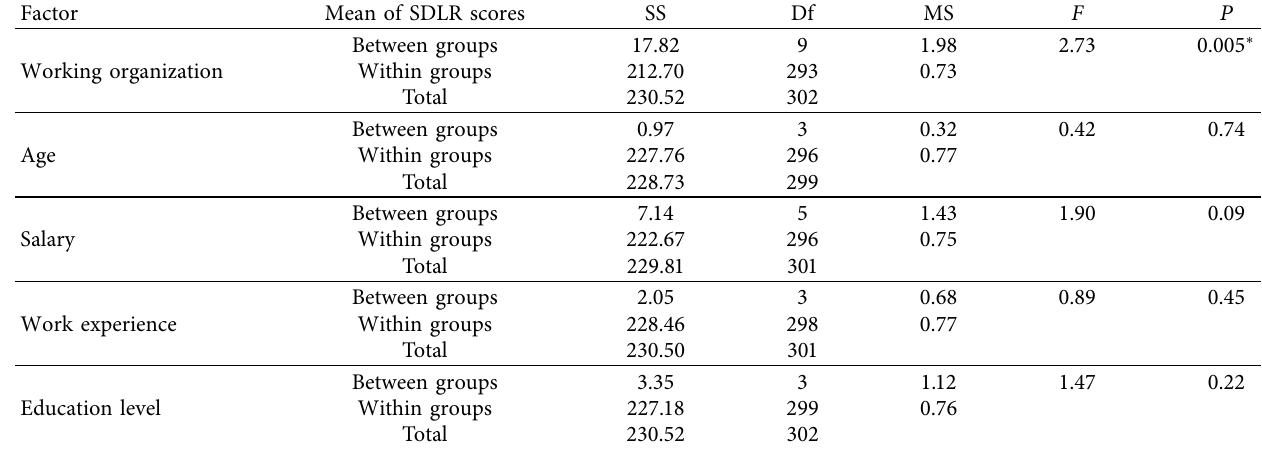
Table 5: ANOVA table of civil servants’ SDLR scores across organizations.